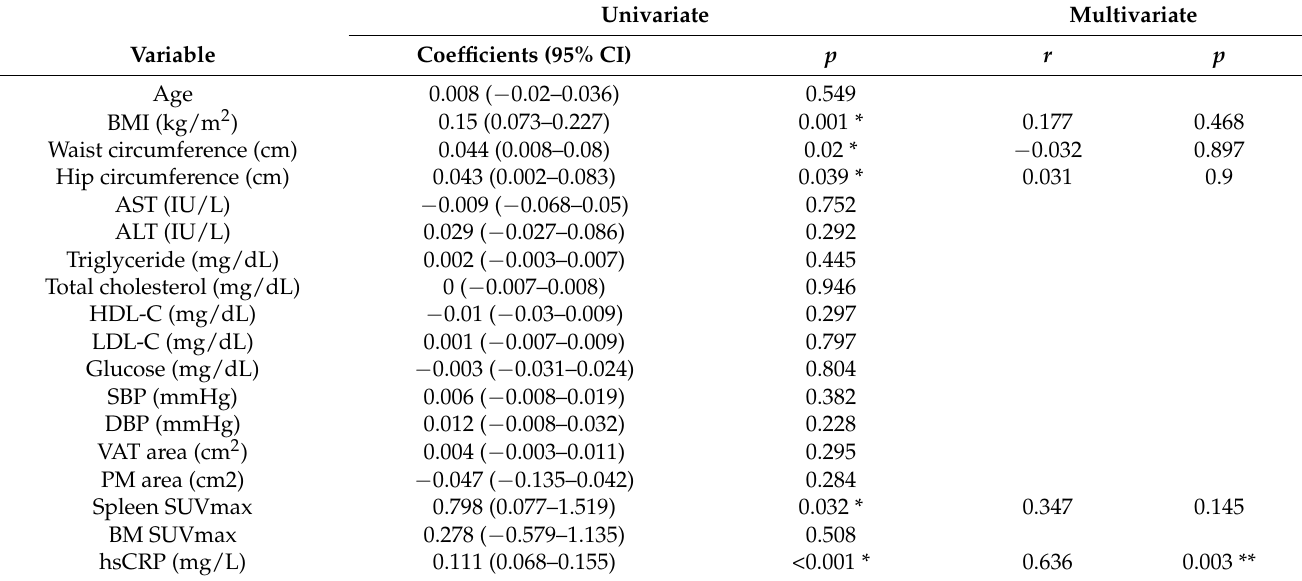
Table 4. Univariate- and multivariate analyses with PM SUVmax at baseline.